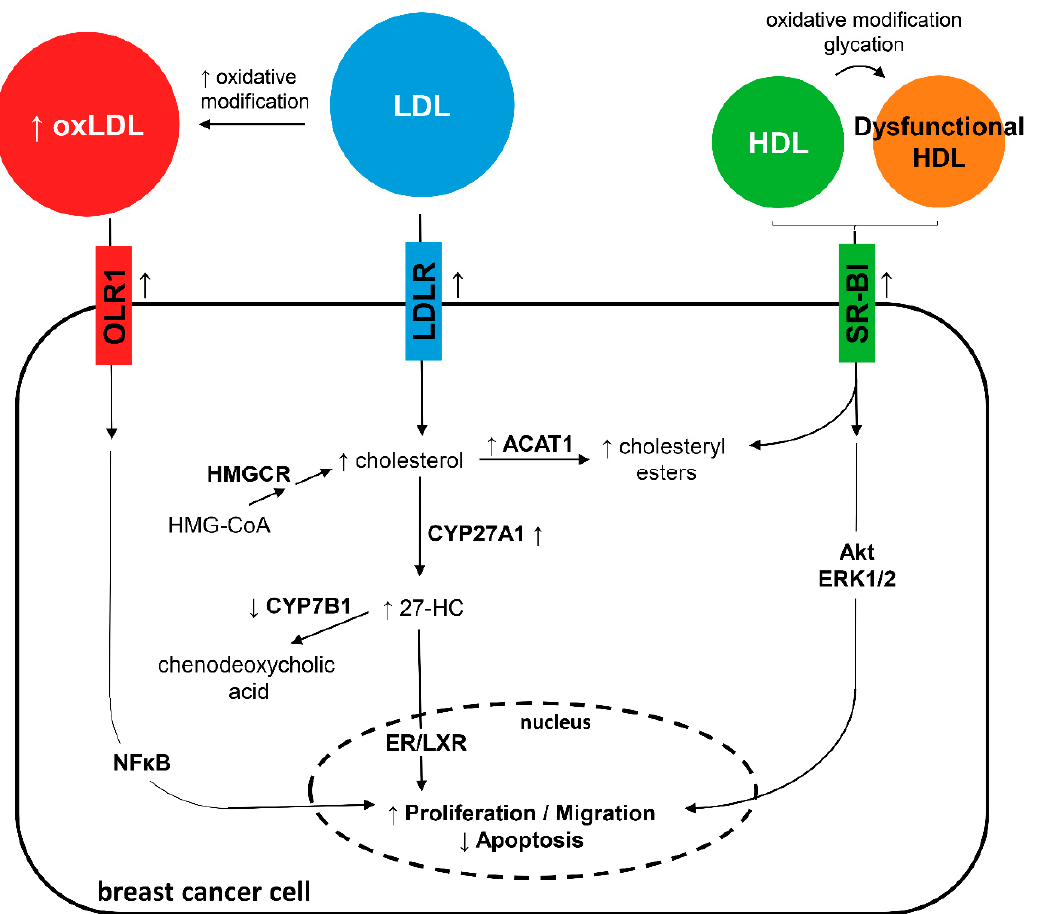
Figure 2. Mechanisms by which low-density lipoprotein (LDL), high-density lipoprotein (HDL), and their modified forms induce proliferation and migration and reduce apoptosis in breast cancer cells. OLR1 = OxLDL lecithin-like receptor 1, LDLR = LDL receptor, SR-BI = scavenger receptor class B type I, HMGCR = hydroxy-methyl-glutaryl-coenzyme A reductase, ACAT1 = acyl-CoA:cholesterol acyltransferase 1, 27-HC = 27-hydroxycholesterol, ERK1/2 = extracellular signal-regulated kinases ½, NF κ B = nuclear factor κ B, and ER/LXR = estrogen receptor/liver X receptor.